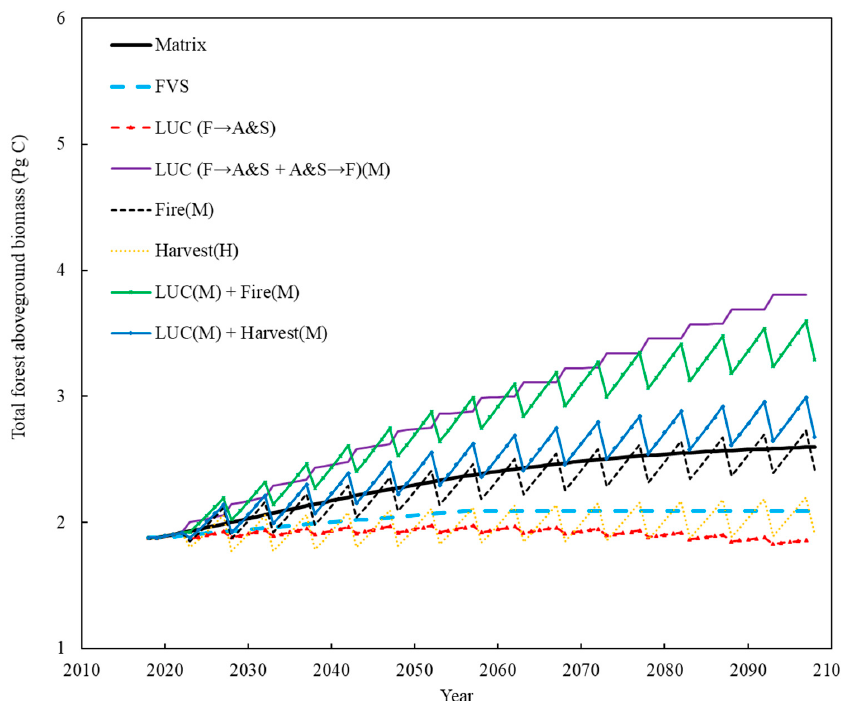
Figure 7. Predicted total forest aboveground biomass (Pg C) by matrix growth models and Forest Vegetation Simulator (FVS) from 2018 to 2098 with selected scenarios of land use change (LUC), disturbances, and LUC + disturbances in the Northern US. Land use change (forest [F] → agriculture and settlements / other [A&S], and A&S → F) includes specific changes from F → A&S and A&S → F. Disturbances include fire and harvest. None represents forests that naturally grow without considering LUC and disturbances. L, M, and H represented low, medium, and high intensity / severity, respectively.